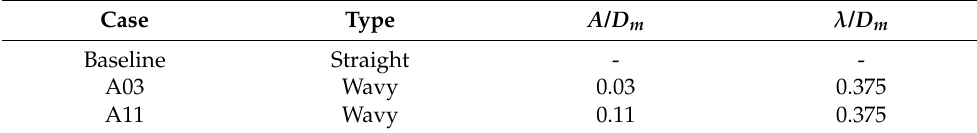
Table 1. Geometry parameters for the models